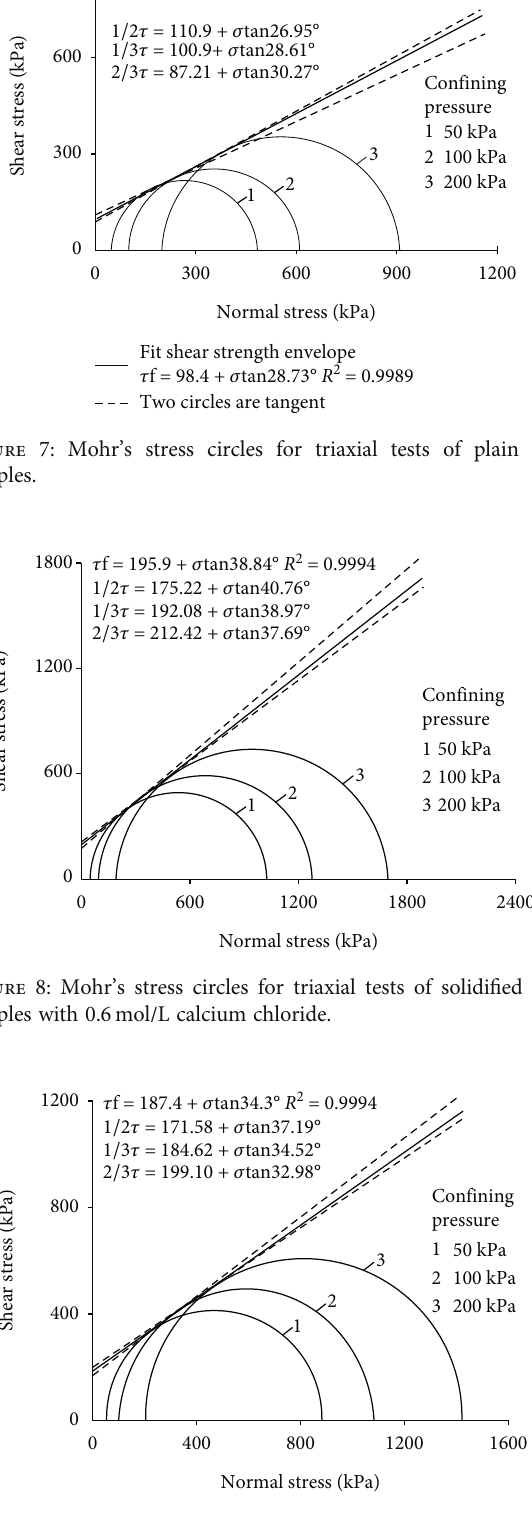
Figure 9: Mohr ’ s stress circles of triaxial tests of solidi fi ed soil samples with 1.0mol/L calcium